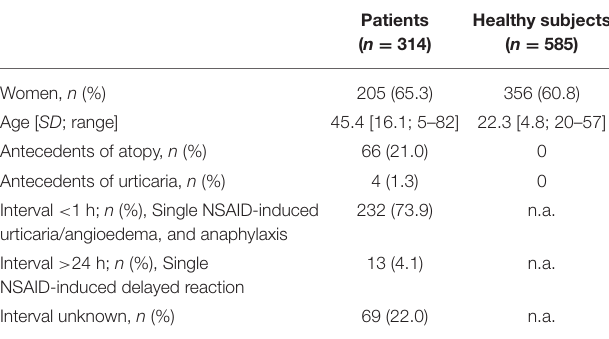
TABLE 1 | Characteristics of the study group.